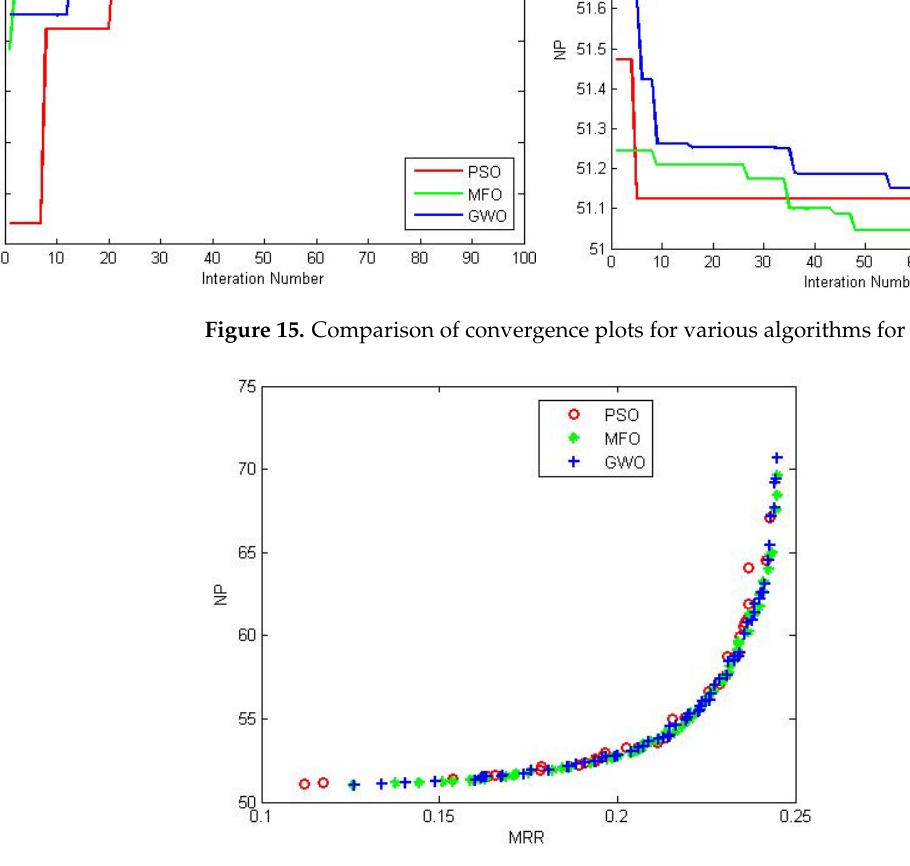
Table 14. The Pareto optimal solutions and their responses for various algorithms. R.No. GWO